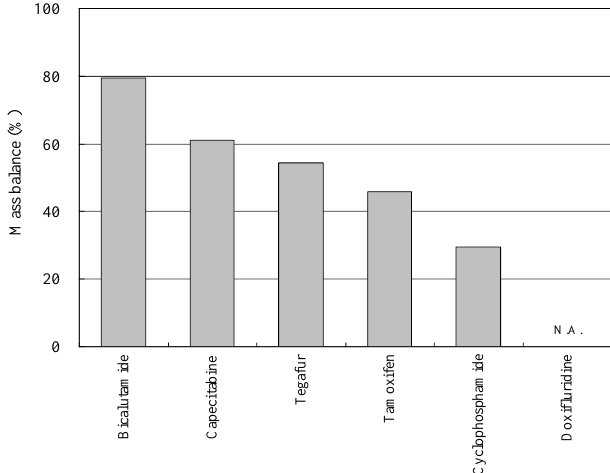
Figure 5. Mass balances of anticancer drugs in the Kanzaki–Ai River basin. N.A.: not available. The abbreviation of each anticancer drug is shown in Table 1 (reproduced from [30]).